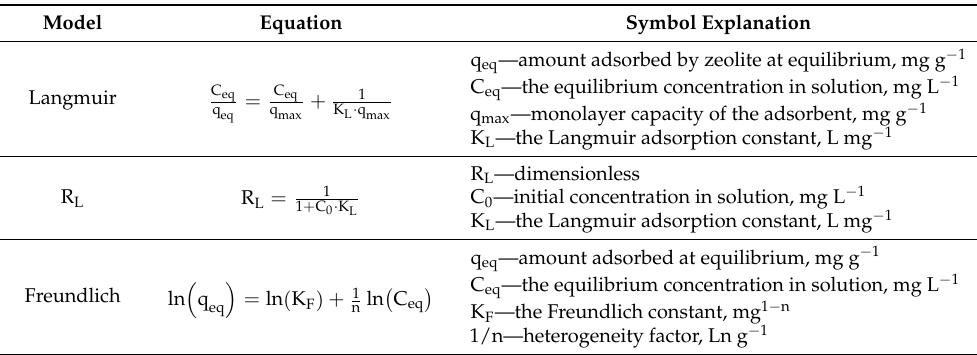
Table 4. Freundlich and Langmuir parameters for the adsorption isotherms.